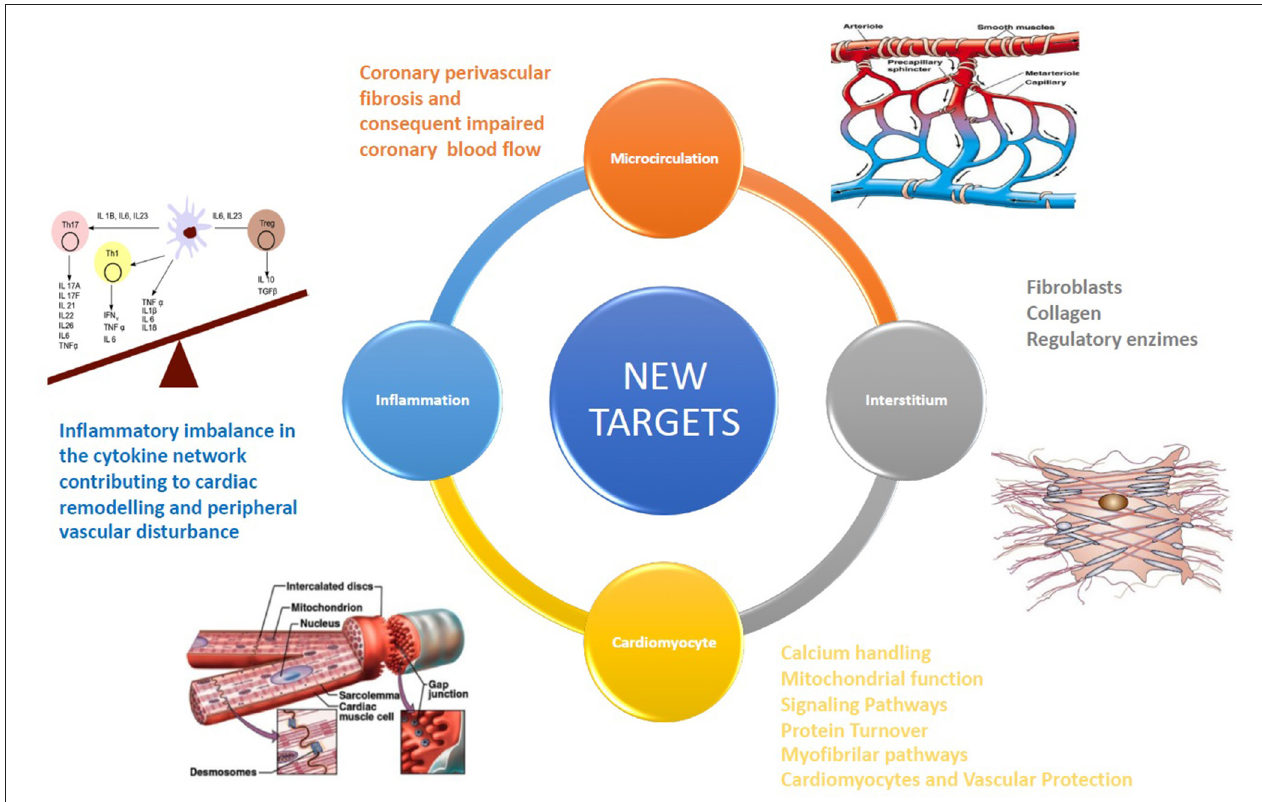
FIGURE 1 | The development of new drugs for HF therapy must be necessarily focused on additional targets, such as cardiomyocytes, coronary microcirculation, and myocardial